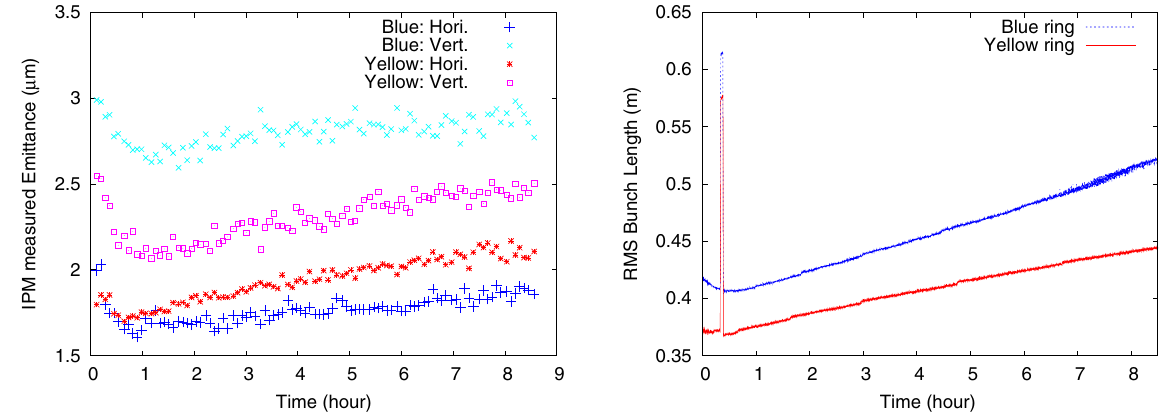
FIG. 4. Evolutions of the IPM measured transverse emittances (left) and the WCM measured rms bunch lengths (right) for both beams at store for Fill